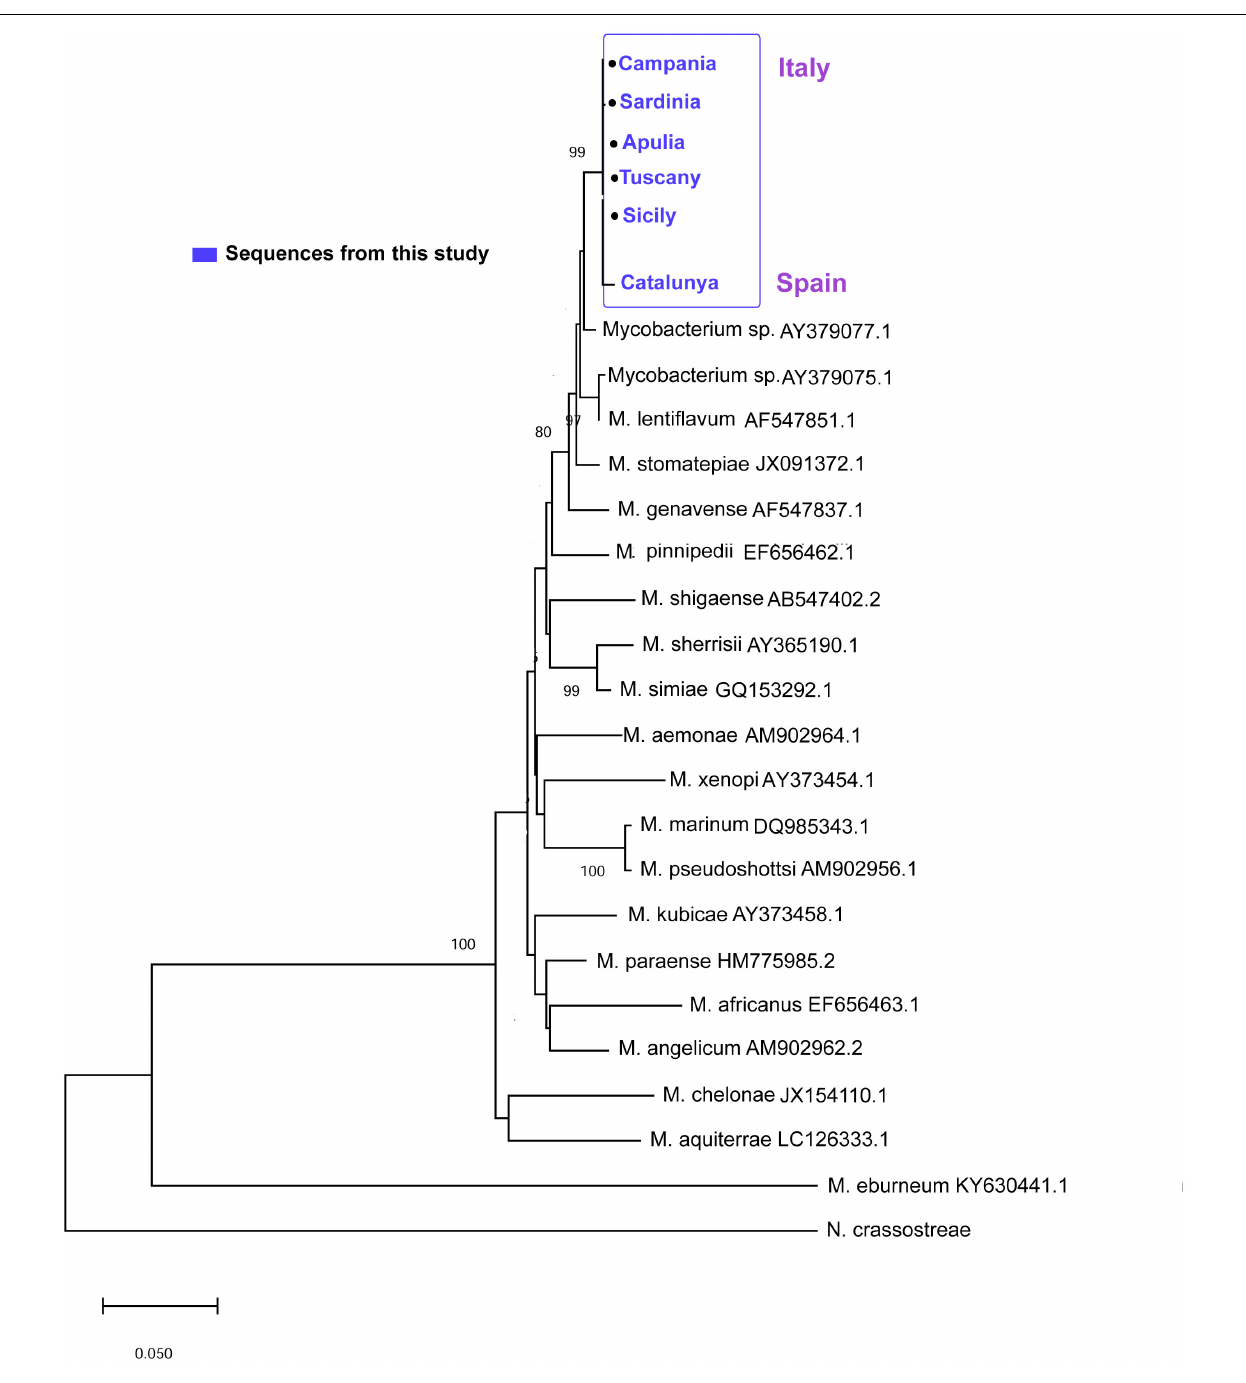
FIGURE 7 | Neighbor-joining tree of the hsp65 sequences. The analysis involved 22 nucleotide sequences and 882 positions in the final dataset. The percentages of bootstrap replicates are shown next to the branches.